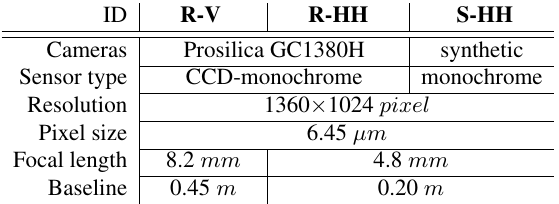
Table 1. IPS camera sensor parameters